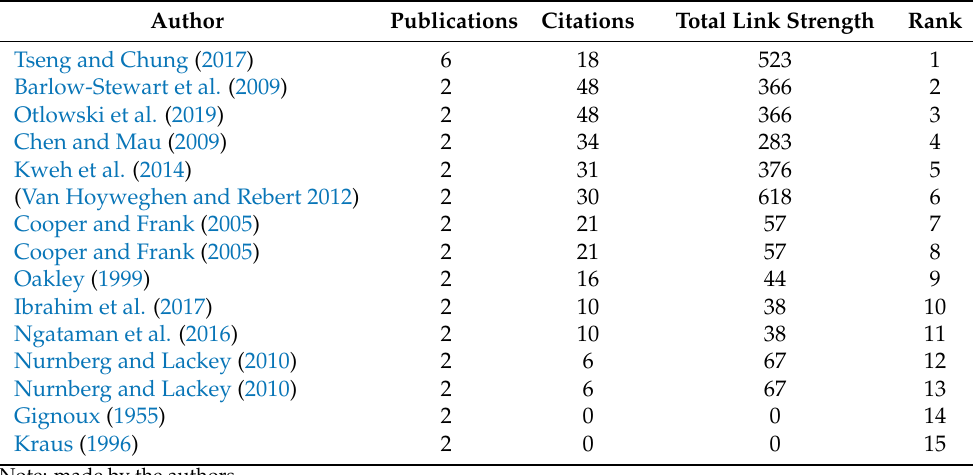
Table 3. Authors with a minimum of two articles in the dataset.